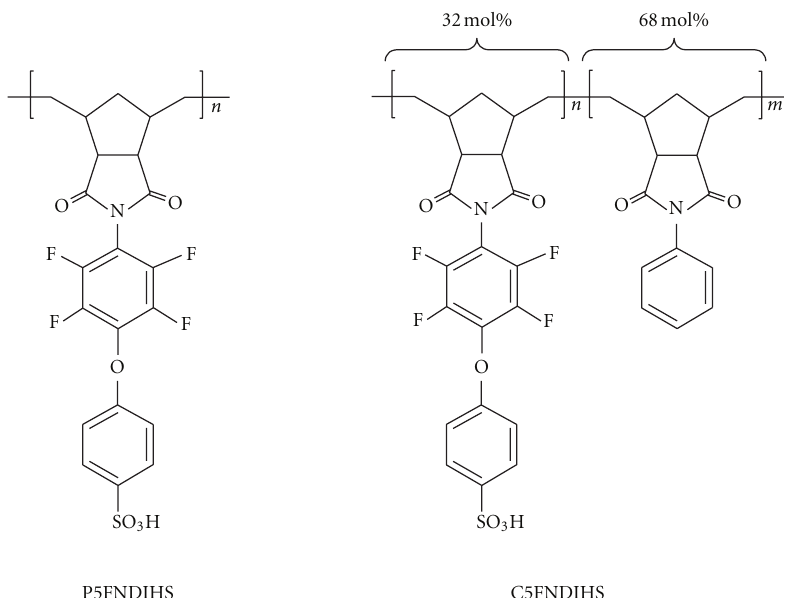
Figure 1: Acid form structural units of hydrogenated-sulfonated poly( N -pentafluorophenyl -exo-endo- norbornene-5,6-dicarboximide) (P5FNDIHS) and hydrogenated-sulfonated poly( N -phenyl- exo-endo -norbornene-5,6-dicarboximide-co- N -pentafluorophenyl- exo-endo - norbornene-5,6-dicarboximide) (C5FNDIHS).